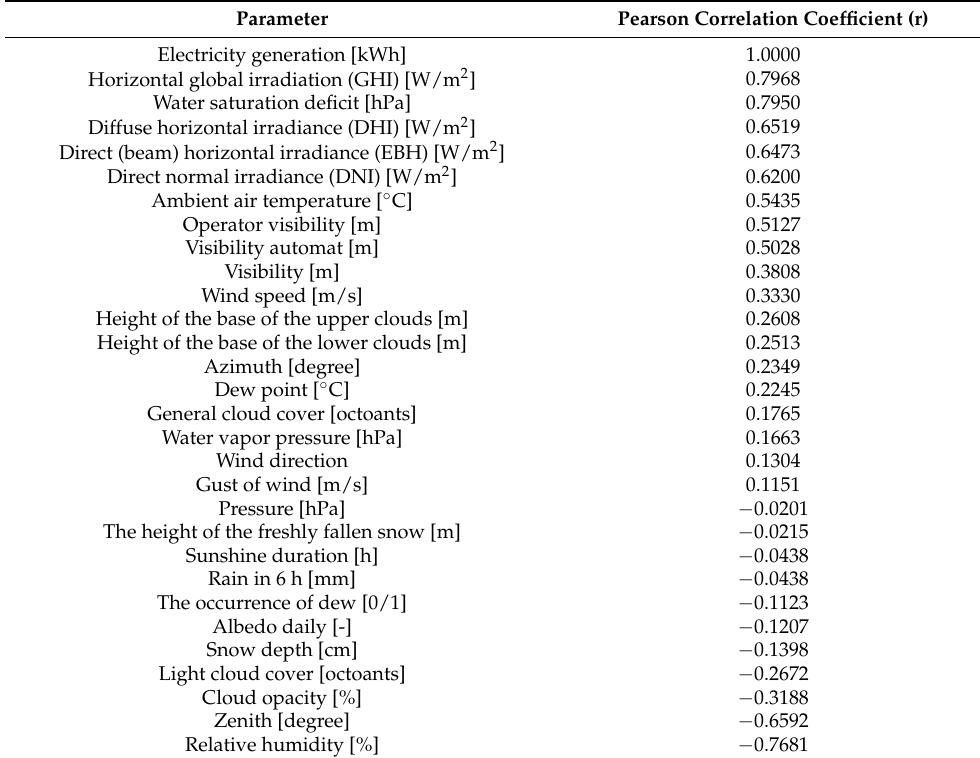
Table 2. The results of the correlation analysis between various meteorological parameters and the electricity generation from the PV power